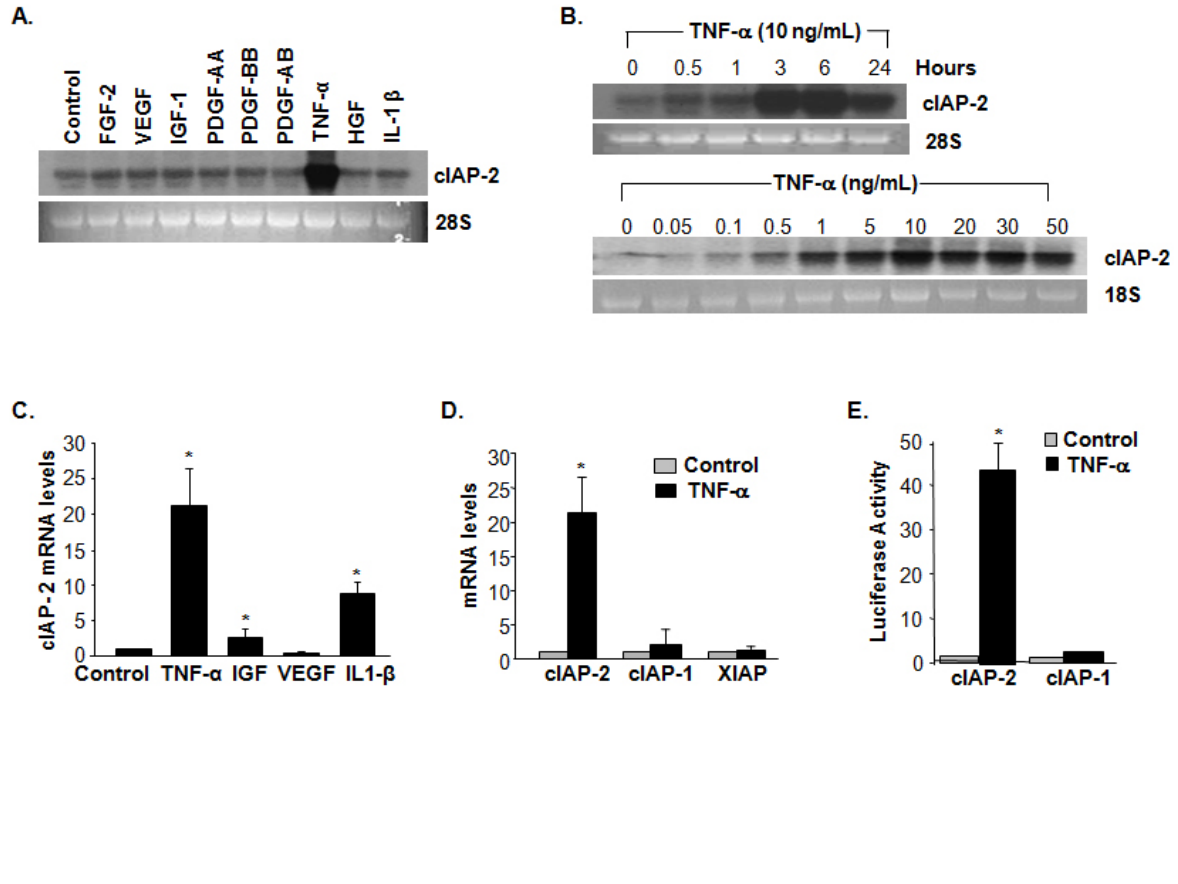
Figure 3. cIAP-2 is upregulated by TNF- α -induced A20. ( A ) Northern blot analysis of cIAP-2 mRNA levels after stimulation with TNF- α (20 ng/mL), FGF2 (25 ng/mL), VEGF (25 ng/mL), IGF-1 (50 ng/mL), PDGF-AA (20 ng/mL), PDGF-BB (20 ng/mL), PDGF-AB (20 ng/mL), HGF (20 ng/mL) and IL1- β (5 ng/mL) in BAECs; ( B ) Northern blot showed TNF- α -induced cIAP-2 mRNA expression demonstrated as a dose-(upper) and time-(lower) dependent manner; ( C ) Quantitative-PCR analysis of cIAP-2 mRNA after stimulation with TNF- α (20 ng/mL), VEGF (25 ng/mL), IGF-1 (50 ng/mL) and IL1- β (5 ng/mL) for 4 h in HAECs. Results are expressed as fold change of control from triplicate tests, and are presented as means ± SD. * p < 0.05; ( D ) Quantitative-PCR analysis of cIAP-1, cIAP-2 and XIAP mRNA levels after stimulation with TNF- α (20 ng/mL) for 4 h in HAECs. Results are expressed as fold changes of control from triplicate tests, and are presented as means ± SD. * p < 0.05; ( E ) Effect of TNF- α stimulation on cIAP-2 and cIAP-1 promoter activity by luciferase activity assay. Results are expressed as fold change to control from triplicate tests, and are presented as means ± SD. * p < 0.05; and ( F ) Targeted knockdown of A20 expression by A20 siRNAs after TNF- α (20 ng/mL) stimulation of cIAP-2 protein expression analyzed by immunoblot ( left ) and mRNA levels by quantitative PCR ( right ). Results are expressed as fold change to control from triplicate tests, and are presented as means ± SD. * p <